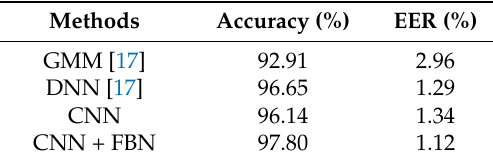
Table 2. Comparison of accuracy and EER for each method based on TIMIT speech database.